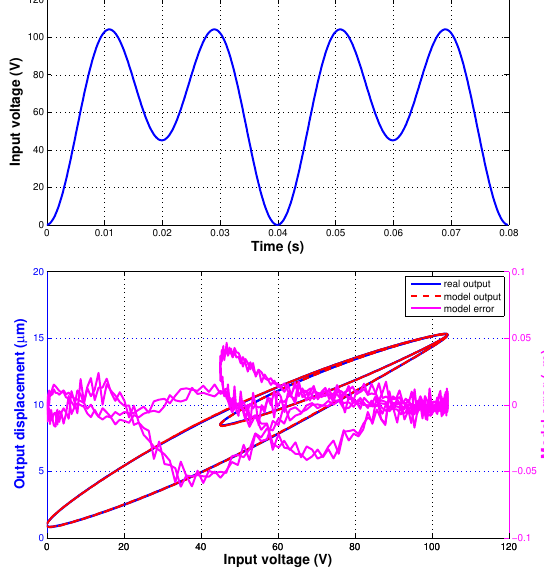
Figure 2. Model Identification: ( top ) input voltage signal, ( bottom ) identification result and